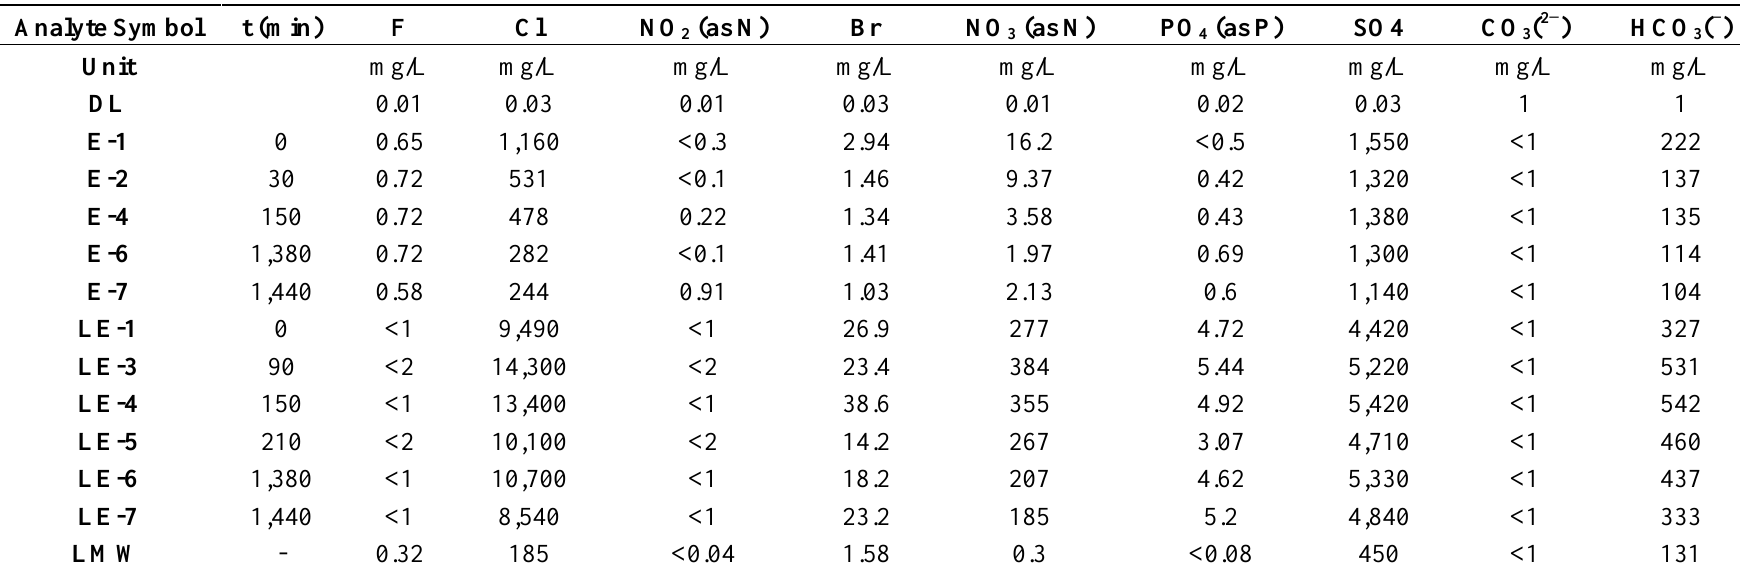
Table 5. Main anions of leachates of pilot-scale experiments. DL: detection limit. Values in